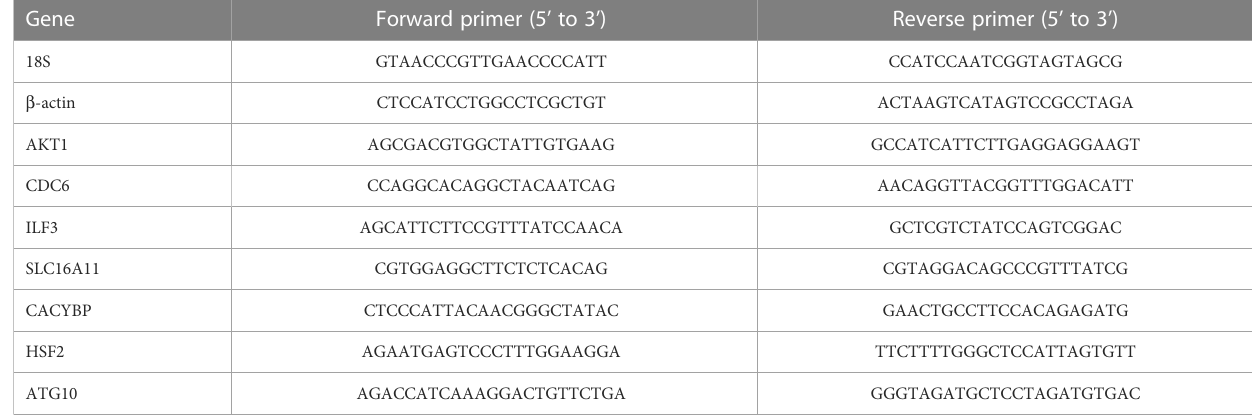
TABLE 1 Primer sequences for real-time PCR in the